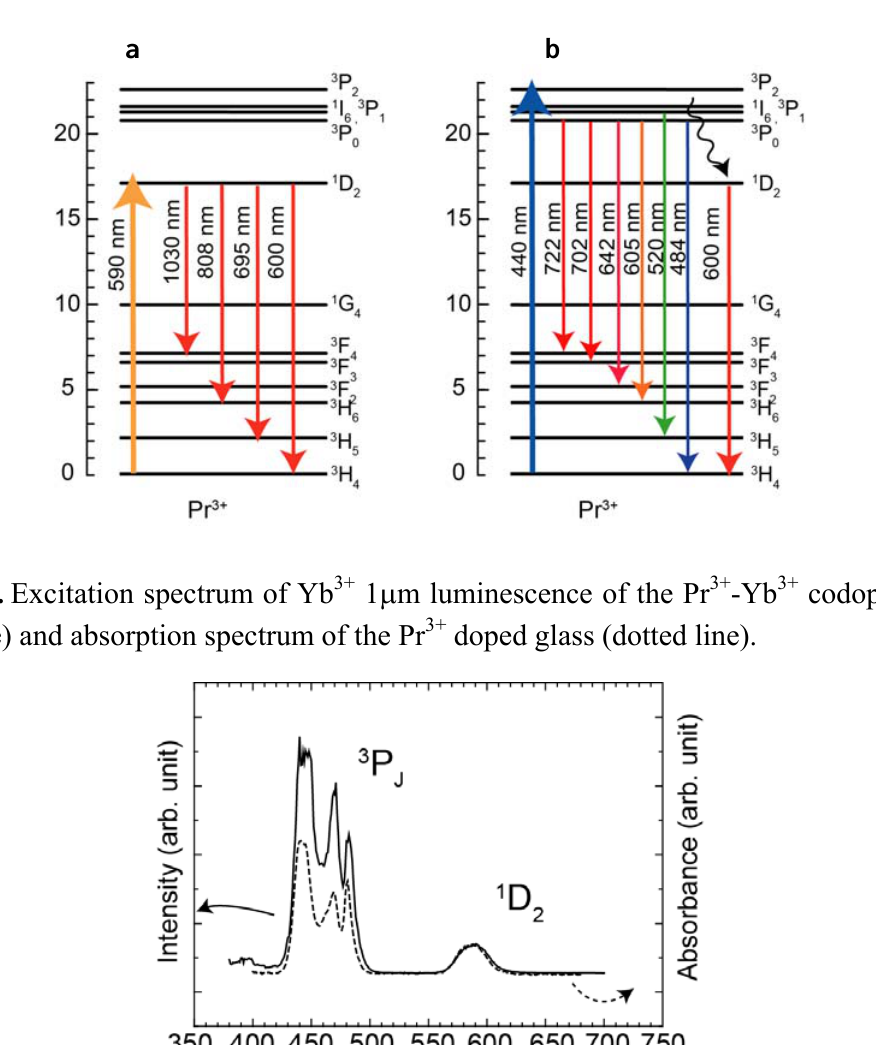
Figure 3. Energy level diagram of Pr 3+ with transitions excited at (a) 590 nm and (b) 440 nm.